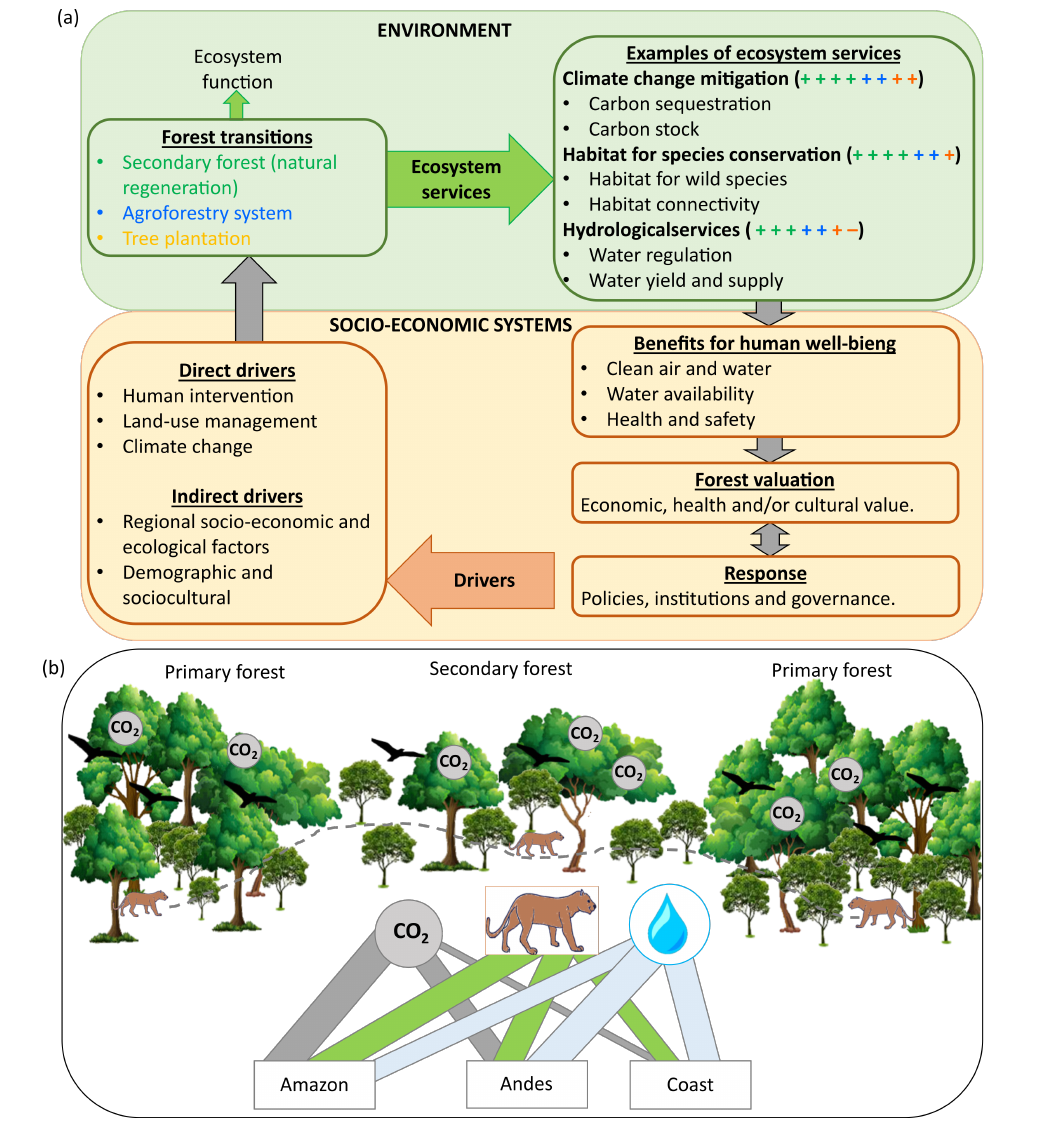
Fig. 4. (A) Framework showing the relationship between the forest transitions, their relative ecological outcomes, and their drivers, linking the environmental and socioeconomic systems. Forest transition is defined as a long period of decline in forest area, superseded by forest recovery. The “+” and “−” represent the potential amount of each service that would be expected to return depending on the forest transition type. (B) The relative importance of key ecosystem services provided by secondary forests in Amazonian, Andean, and coastal